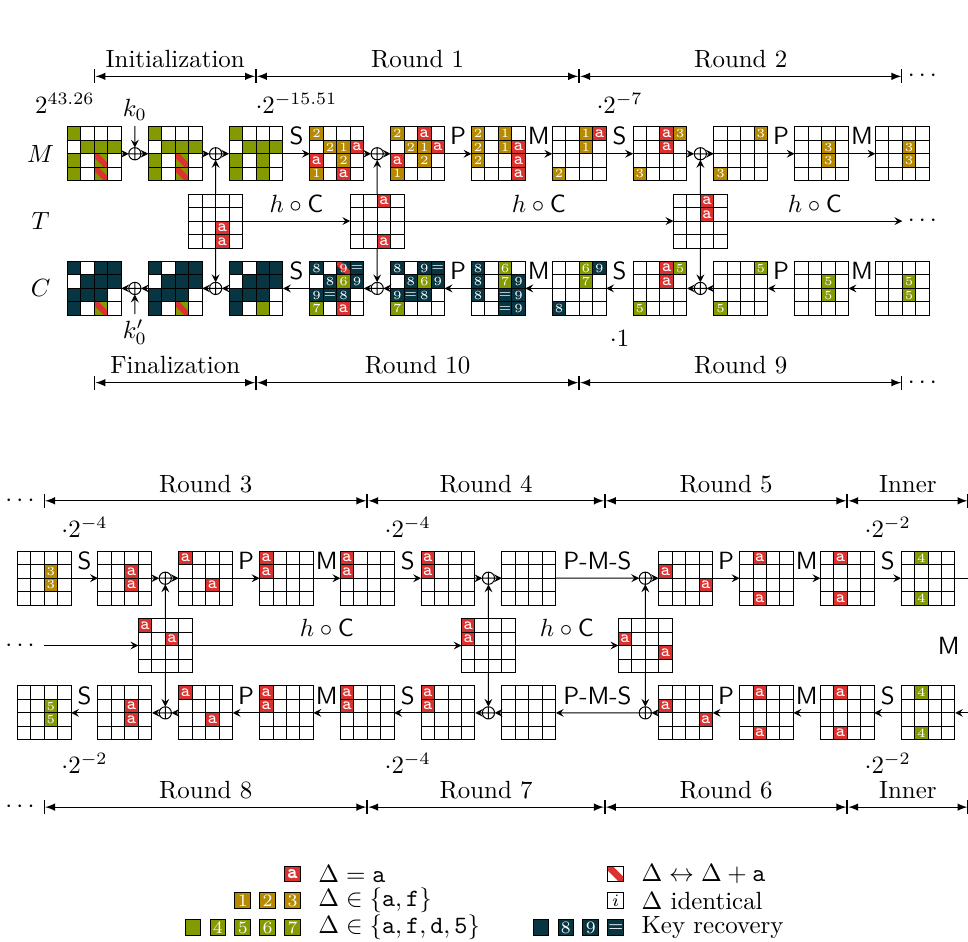
Figure 5: Family of differential characteristics for MANTIS 5